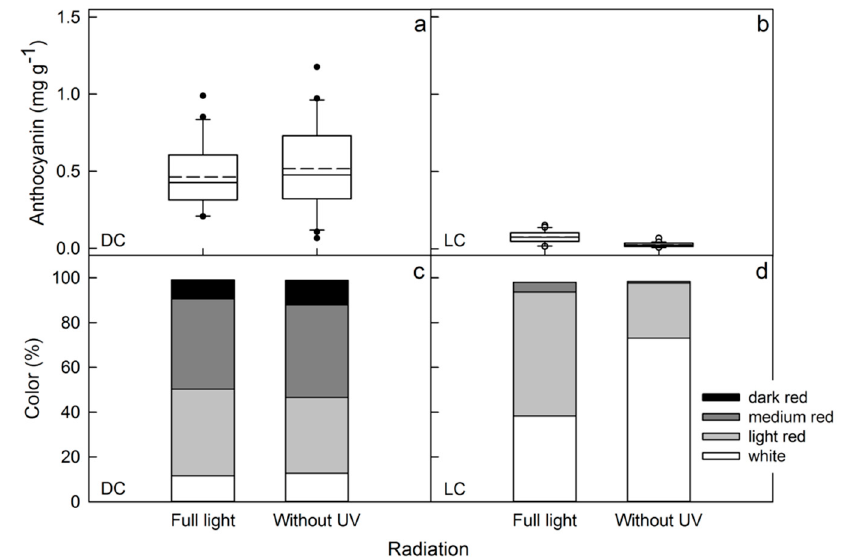
Figure 7. Effect of UV radiation on the anthocyanin content ( a , b ) and the color distribution ( c , d ) of red flesh apples of a dark-colored (DC) ( a , c ) and a light-colored (LC) clone ( b , d ). UV radiation was excluded by wrapping the fruit in a bag made of UV-absorbing film. The film absorbed 100% of the UV radiation. Fruit that was exposed to full sunlight served as control.